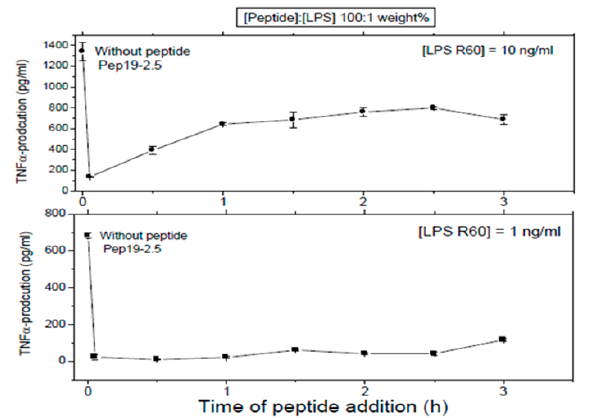
Figure 8. Production of TNF α by MNC cells that were first exposed to LPS and then incubated with peptide Pep19-2.5 [LPS R60]/[Pep19-2.5] 1:100 weight % at different time points from 0 to 3 h after LPS exposure. Mean values and standard deviations due to the determination of TNF α in